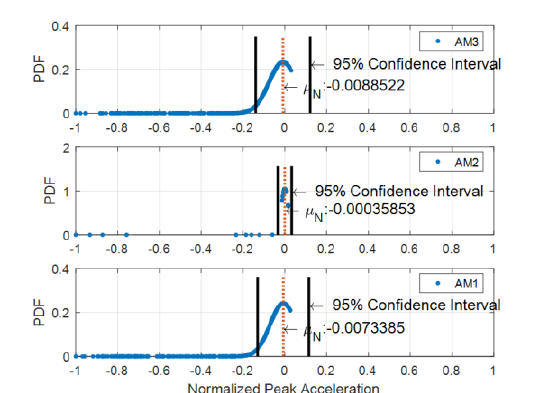
Figure 9 Probability density curves of the raw